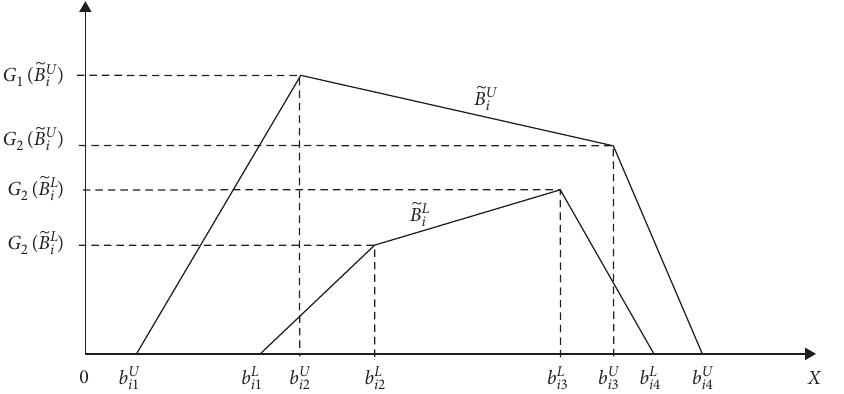
􏽥􏽥 B 􏽥 B L i i of the T1FS